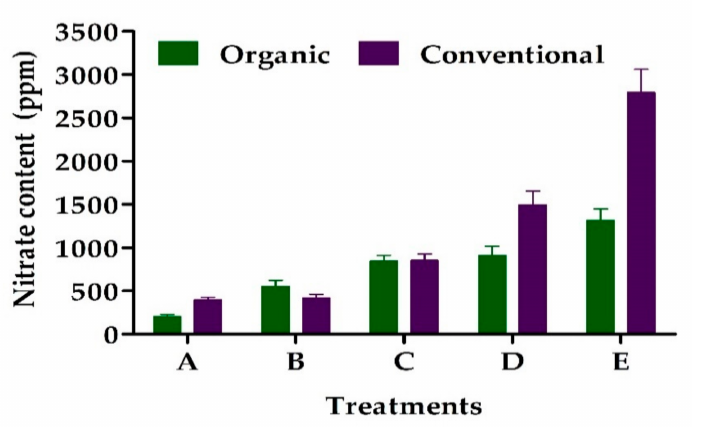
Figure 2. Nitrate (NO 3 − ) content of organic and conventional broccoli (A), cabbages (B), lettuce (C), celery (D), and spinach (E) in the USA. Source—de Gonz á lez et al.